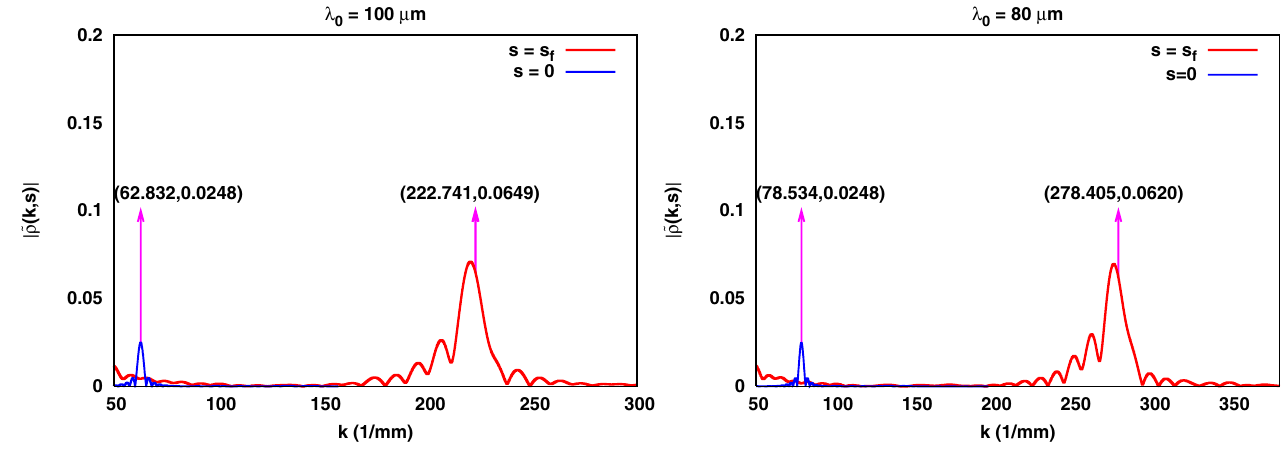
¼ 100 (cid:4) m (left) and (cid:2) for (cid:2) f 0